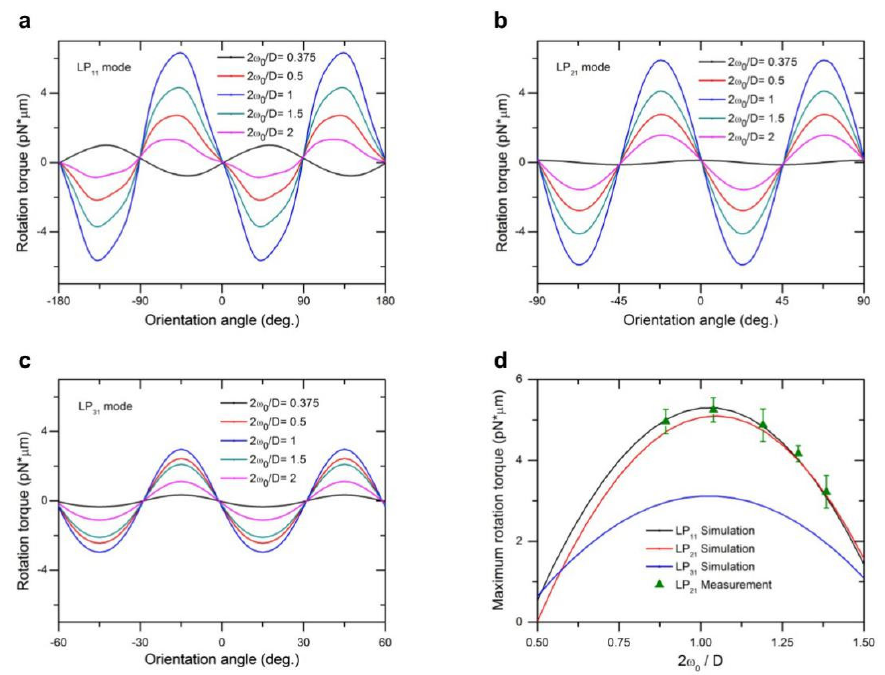
Figure 5. Optical torque generated by LP 11 , LP 21 , and LP 31 modes as a function of orientation of spheroid cell with respect to radial mode field distribution. ( a )–( c ) For LP 11 , LP 21 , and LP 31 mode field, respectively, rotation torques as a function of cell orientations and for different 2 ω 0 /D ratios; ( d ) The calculated and measured maximum rotation torque as a function of 2 ω 0 /D ratios for P = 10 mW and 2 0 = 4.8 μm.